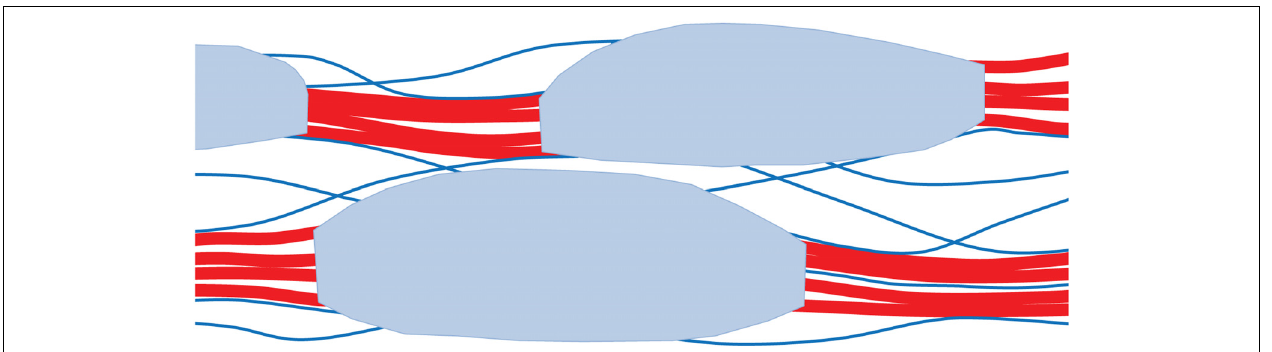
these glucomannans bridge between the aggregates. For clarity the structure is shown much more open than is the case: the free space, filled by water in vivo , is only about 40% of the total volume.This is much less than the free space in hydrated primary cell walls. Based onTerashima etal. (2009) and Fernandes etal.